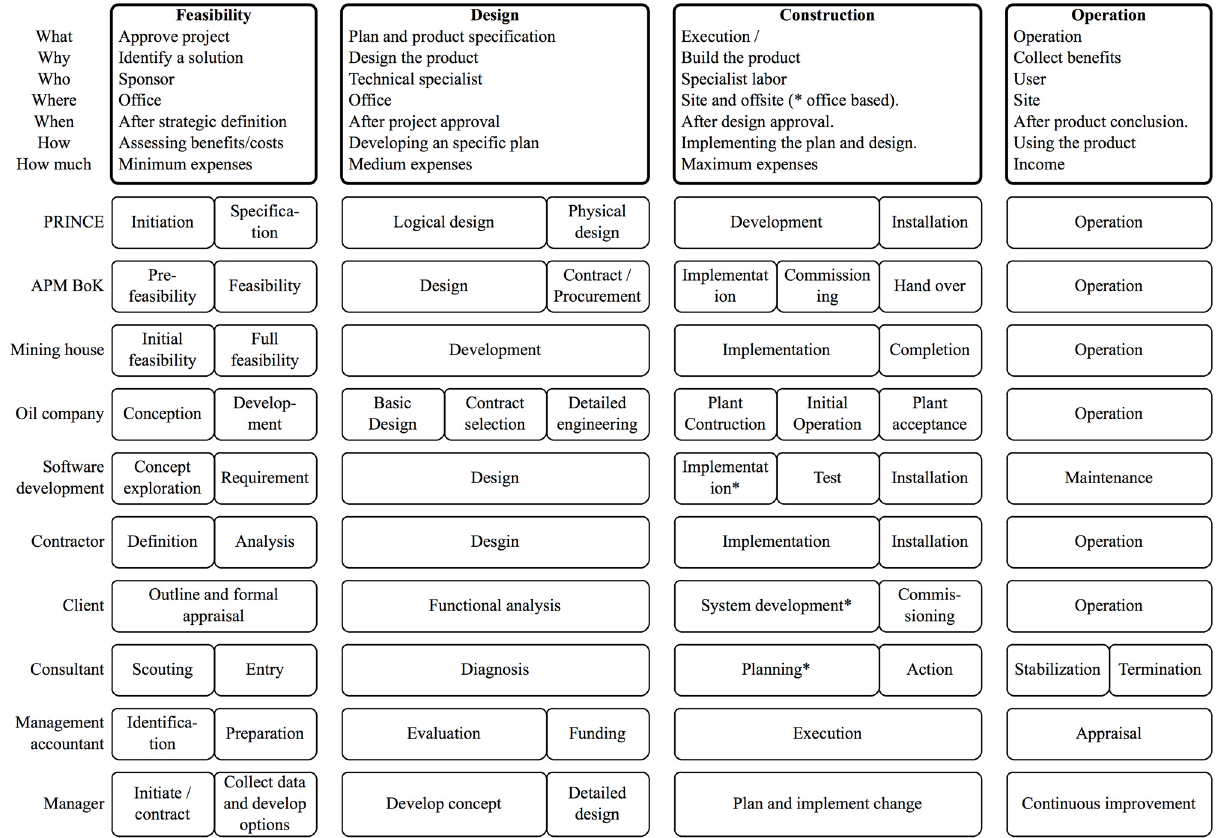
Figure 1. Characteristics of project stages (projects stages of various approaches adapted from Smith, Merna and Jobling [48], originally from McGetric, The Project Life Cycle, 1996). For additional information about the Project in Controlled Environment (PRINCE) and Association for Project Management Book of Knowledge (APM BoK), refer to [34] and [49],